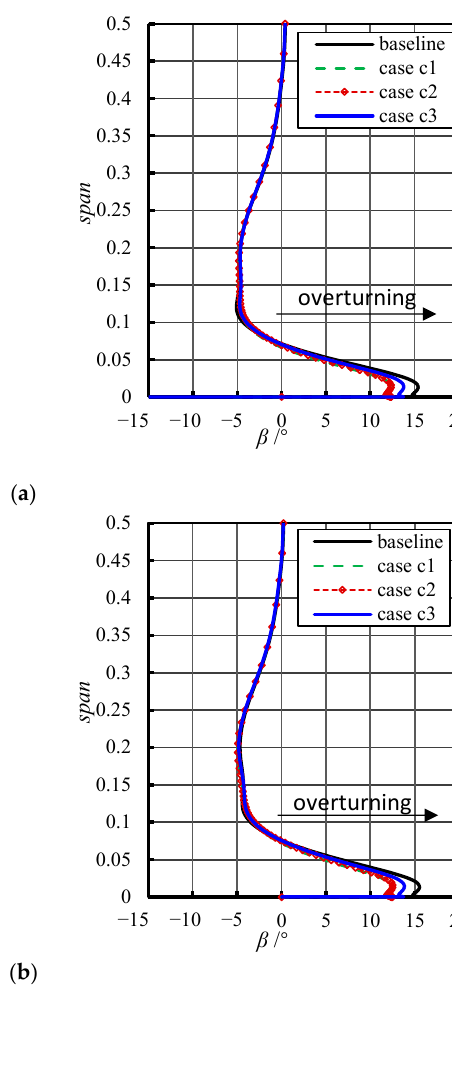
Figure 9. The overall total pressure loss ( c p ) for the three end wall contouring cases.